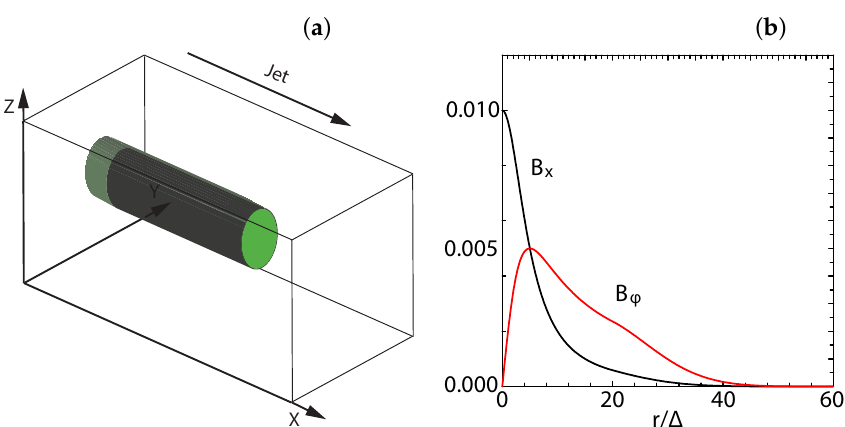
Figure 6. Panel ( a ) shows a schematic simulation setup; a global jet setup. The jet is injected at x = 100 ∆ with the jet radius r jet at the center of the y − z plane (not scaled). Panel ( b ) shows the helical magnetic fields, B x ( black ) , B φ ( red ) with B 0 = 0.01 for the pitch profile α = 1.0 with damping functions outside the jet with b = 200.0. The jet boundary is located at r jet = 20 ∆ [61]. So far, simulations were performed with r jet = 20,40,80,120 ∆